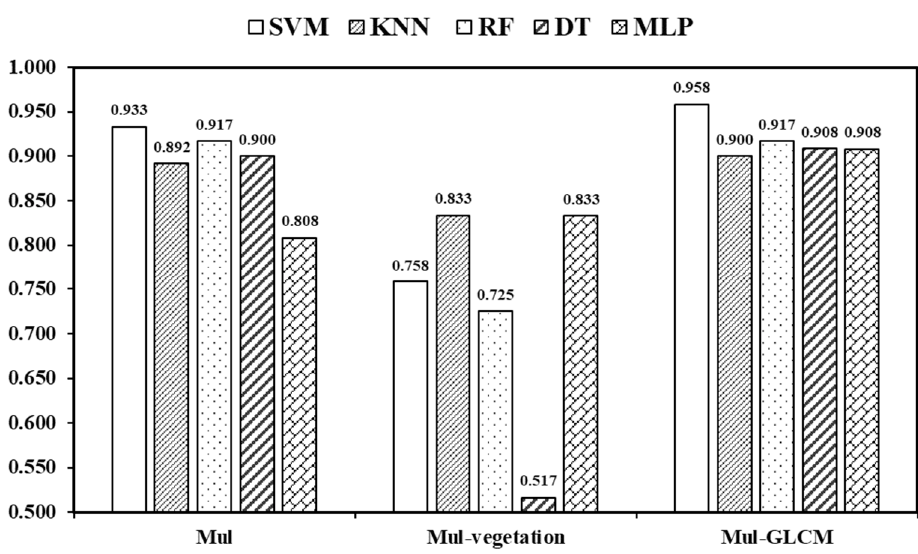
Figure 7. Forest land resource information Overall accuracies (OA) of three features based on four algorithms.